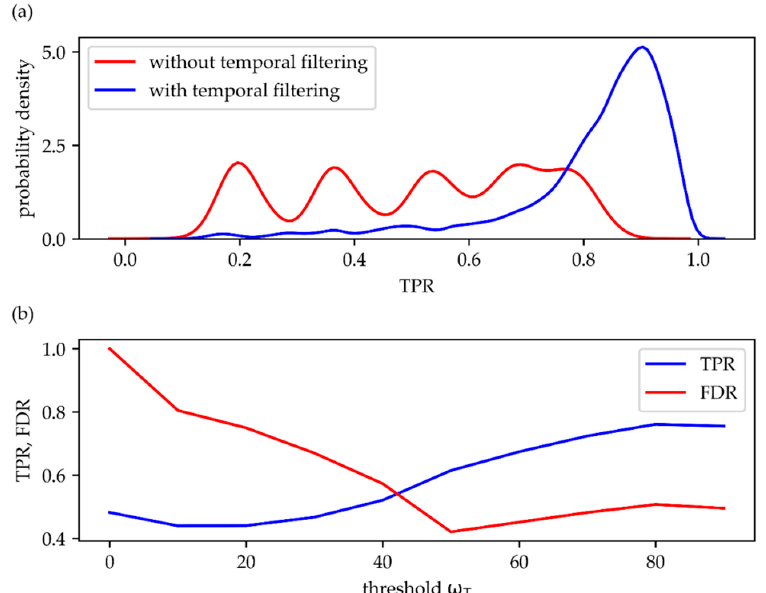
Figure 6. Quantitative comparison of analyzed data without and with temporal filtering. ( a ) The distributions of the obtained TPR without (red) and with (blue) temporal filtering. Data include simulations with varied parameters for B, τ on , τ off , ω T . (b) Plot of the dependence of TPR (blue) and FDR (red) on the threshold ω T . Panel ( a ) was analyzed with 3D-DAOSTORM [22], panel ( b ) with the algorithm by Gao et al. [23].